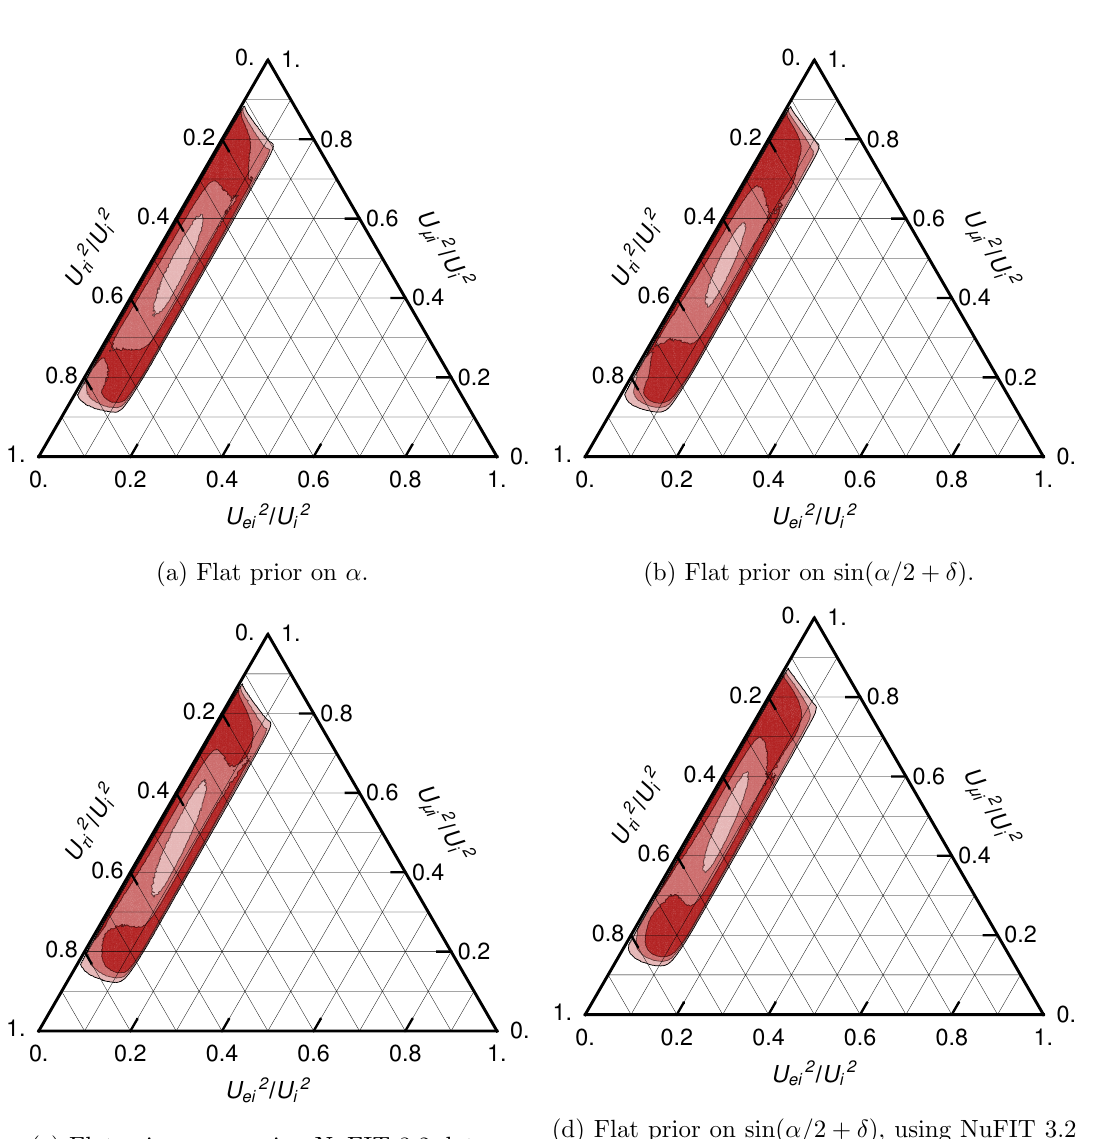
Figure 3. The di(cid:11)erent shades indicate the 1 (cid:27) (darkest), 2 (cid:27) and 3 (cid:27) (lightest) probability contours for the ratios U 2 =U 2 for n = 2 and NO that can be obtained from present neutrino oscillation a data. The upper Panels (a, b) are based on the results from the NuFIT 3.1 global (cid:12)t to